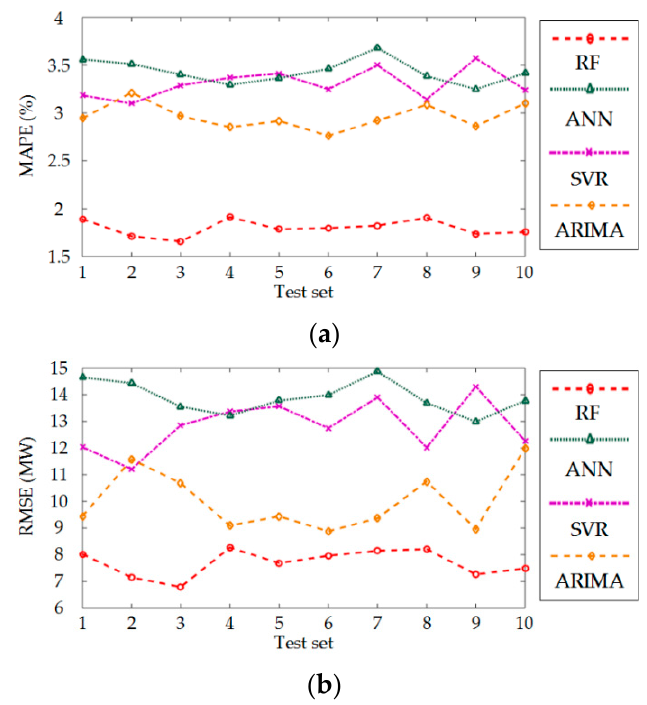
Figure 12. ( a ) MAPE of four predictors on the 10 test sets when day ‐ ahead prediction is conducted; ( b ) RMSE of four predictors on the 10 test sets when day ‐ ahead prediction is conducted.